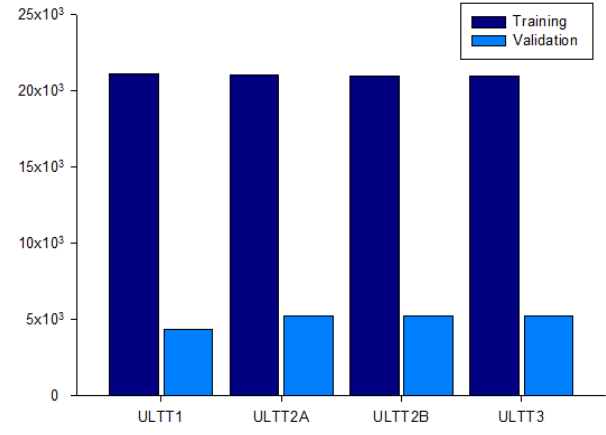
Figure 3. Dataset for the distribution of 103,116 ULTT images.